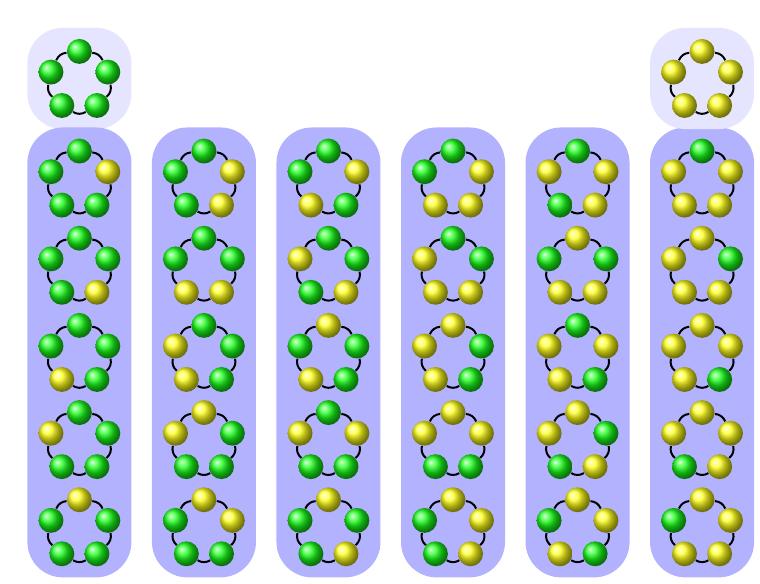
Fig. 6. Orbits of necklaces with 5 beads in 2 colours under cycle action by Z + 5 . The monocoloured necklaces (top left and top right) each has orbit of size 1 . The multicoloured necklaces have orbits in a regular pattern, in sets of size 5 . By Orbit-Stabilizer theorem, the possible orbit sizes of necklaces are 1 or 5 , since n = 5 is prime.